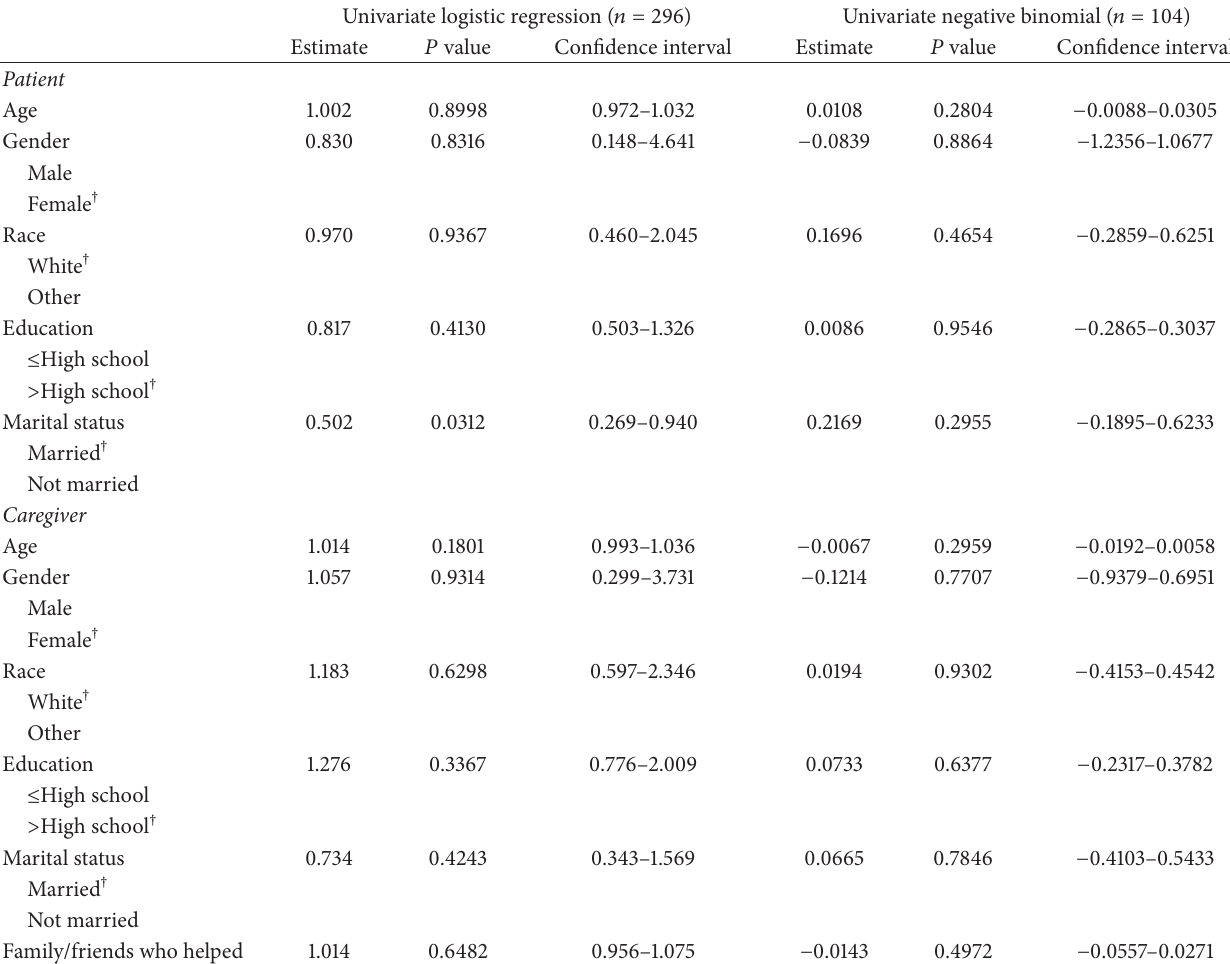
Table 3: Predisposing factors ∗ for veterans’ utilization of inpatient